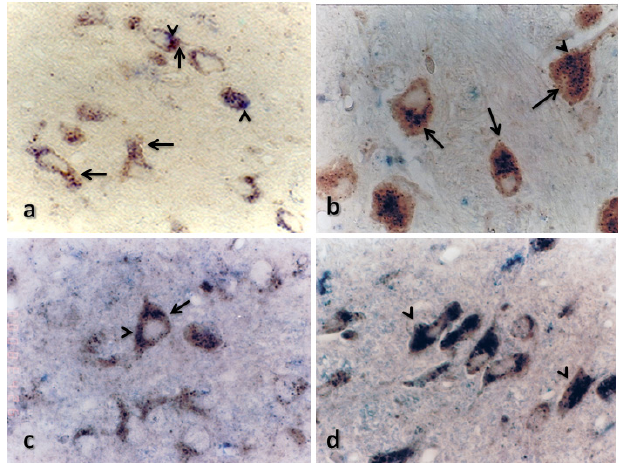
Figure 7. Effect of TBI on the immunoreactivity of cathepsin B and CC in the pontine nuclei. Representative micrographs showing the change in the immunoreactivity of cathepsin B (brown) and CC (purple) in rats killed either before TBI ( a ) or at 24 ( b ), 48 ( c ) or 72 ( d ) h after TBI. Both proteins were detected in control rats, and the expression levels increased after 24 h and are sustained at 72 h after TBI. Magnification: 100×. Arrows indicate cathepsin B staining, and arrowheads indicate cystatin C